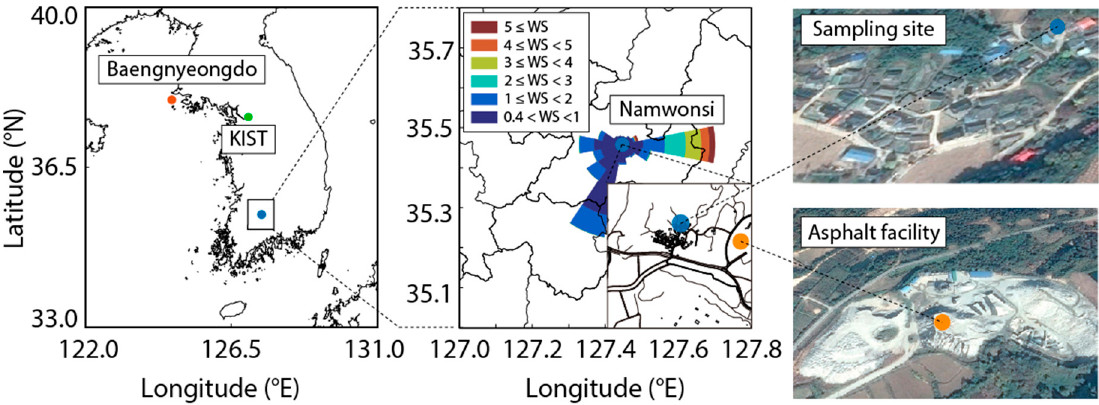
Figure 1. Characteristics of wind direction and wind velocity at the locations and sampling sites used in the study.